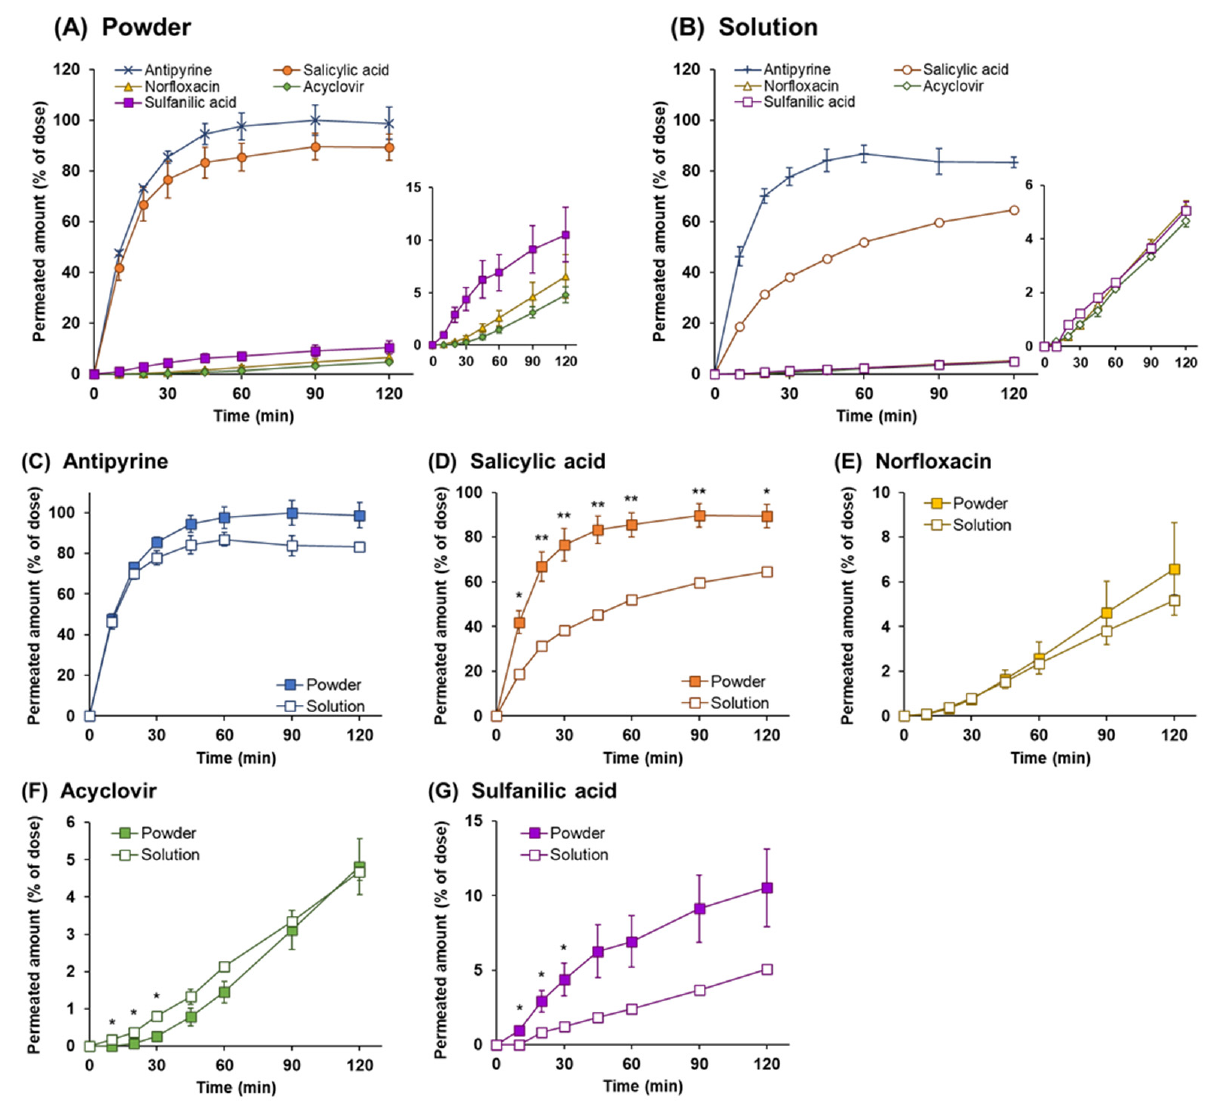
Figure 4. Time profiles of drug permeated amount through Calu-3 cell layers. Drug permeation behaviors are shown for the following: ( A ) powder and ( B ) solution applications using five model drugs, antipyrine (×), salicylic acid ( ● ), nor fl oxacin ( ▲ ), acyclovir ( ◆ ), and sulfanilic acid ( ■ ). The profiles with different vertical axis for norfloxacin, acyclovir, and sulfanilic acid are represented in a separate panel on the right of each graph. ( C – G ) The characteristics between the dosage forms are shown in a graph with each model drug as a solid square for powder and an opened square for solution. The data are represented as the mean of independent experiments, with the vertical bars indicating the S.E. (n = 3–5). Statistical significances are represented in ** p < 0.01 and * p < 0.05 compared with each dosage